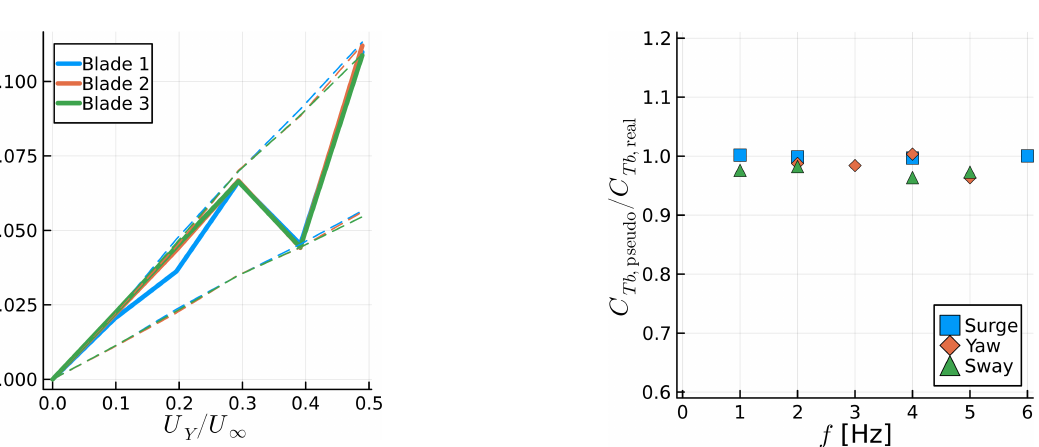
Figure 25. Ratio between mean blade thrust for pseudo-motion and real-motion simulations for various frequencies and motion